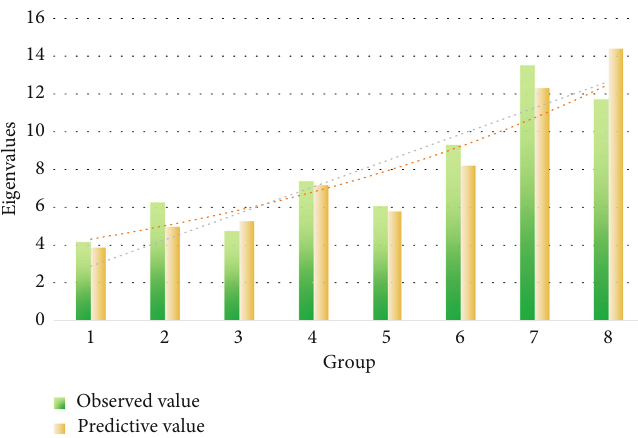
Figure 1: Comparison of the observed and predicted values for the occurrence of cardiovascular events.